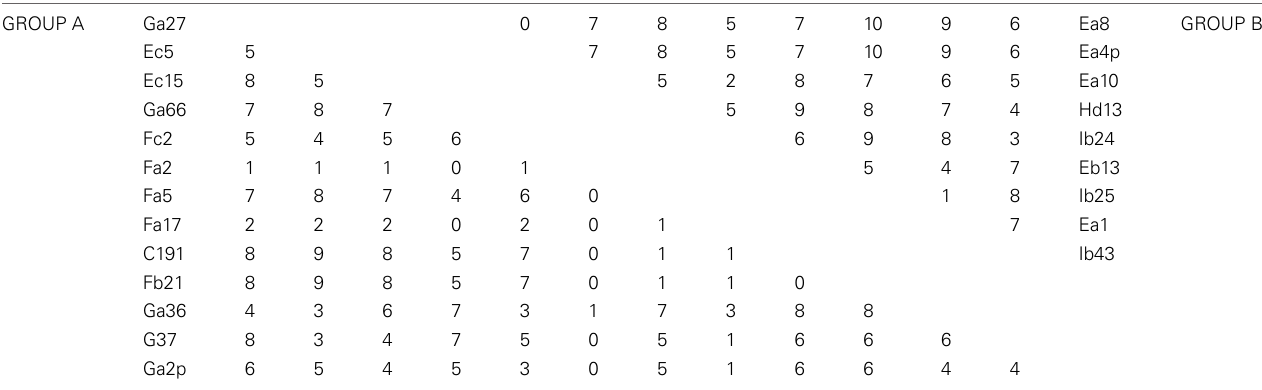
Table 4 | Pairwise comparison of number of nucleotide differences within polytomous Groups A and B defined on the maximum likelihood